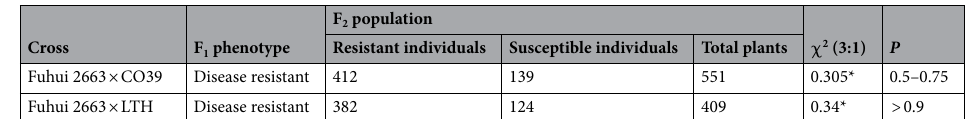
Table 1. Resistance of Fuhui 2663 and hybrid offspring to the rice blast isolate KJ201. *Denotes that the segregation ratio of resistant plants to susceptible plants complied with 3:1 at the 0.05 significance level.